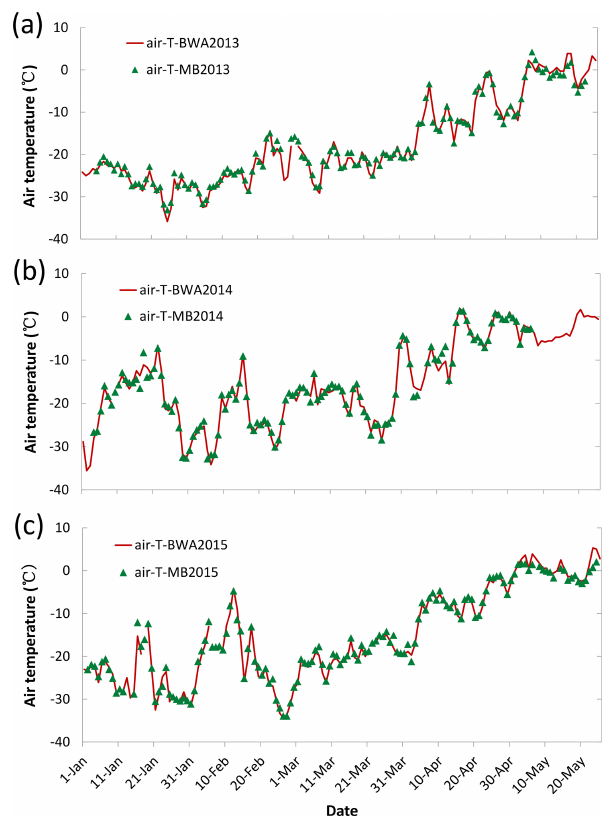
Figure 6. Comparison of air temperature observed at WSO AP (Utqia˙gvik Weather Service Office airport weather station) and the MB site during January–June 2013 (a) , 2014 (b) and 2015 (c) .